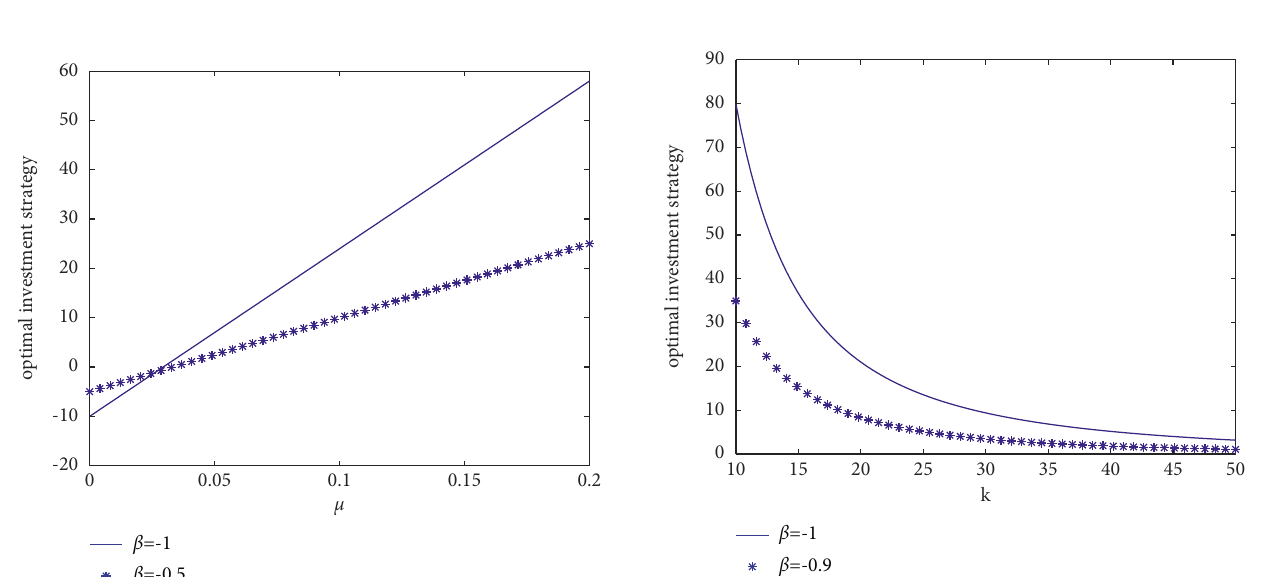
Figure 2: Influence of μ on optimal investment ratio π ∗